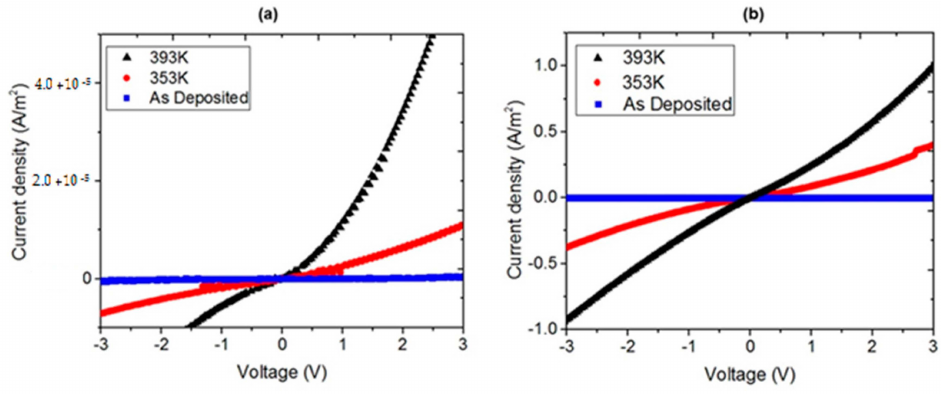
Figure 7. J - V characteristics of ( a ) CuPc and ( b ) ZnPc devices at different annealing temperatures.